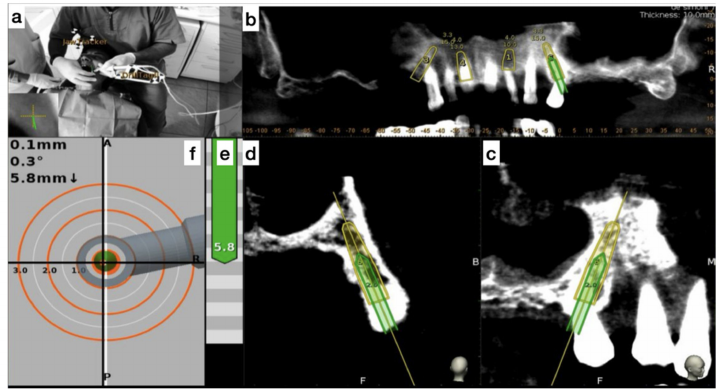
Figure 5. The figure indicates the several views on the screen during surgery and the advancing of the drill into the bone. ( a ) Tracker video stream, ( b ) panoramic view, ( c ) mesiodistal section view, ( d ) Bucco-lingual section view, ( e ) depth indicator, and ( f ) target view.